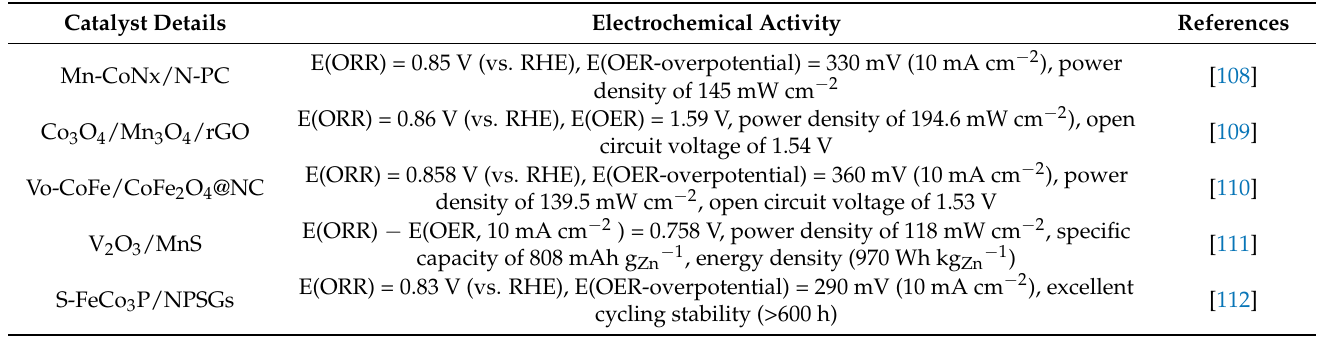
Table 2. Summary of electrocatalysts application in Zn–air